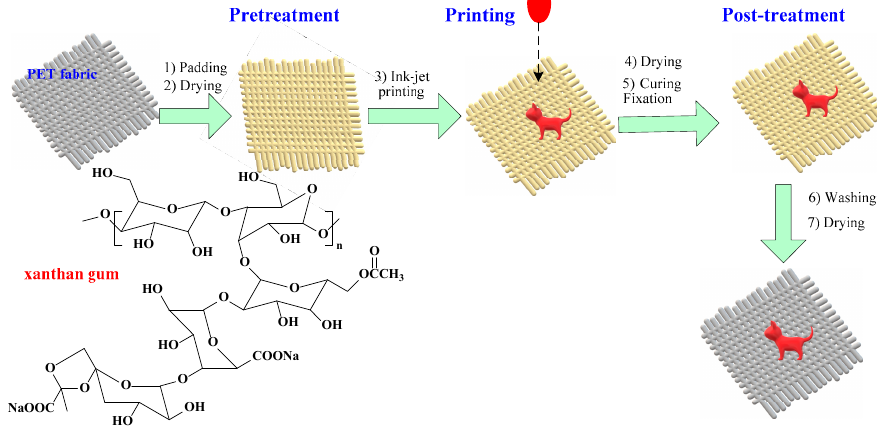
Figure 1. Flowchart of printing process on the pretreated polyethylene terephthalate (PET)